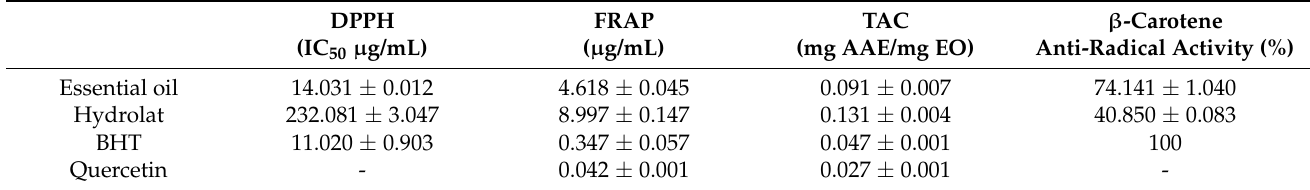
Table 2. Antioxidant activities of essential oil and hydrolat from W. frutescens